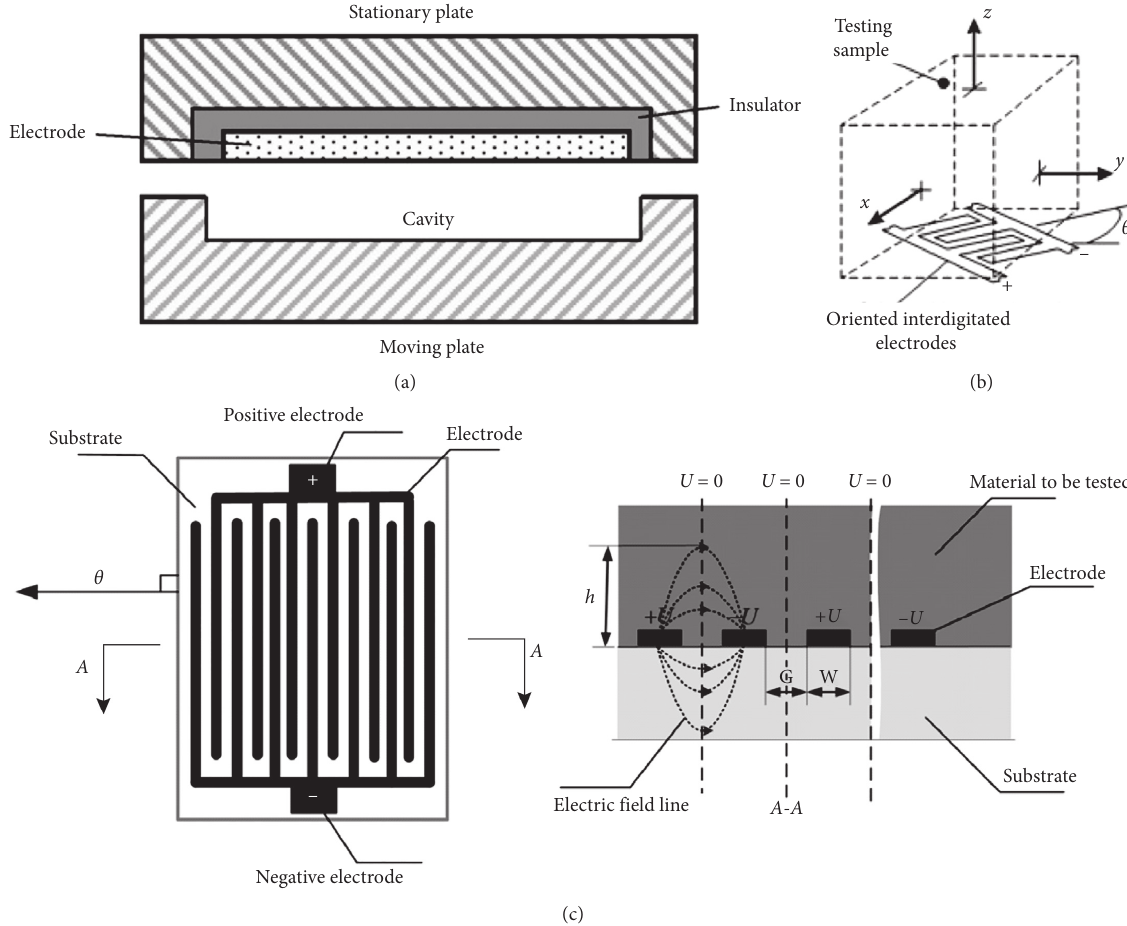
Figure 8: (a) Schematic view of the capacitive transducer installed in the injection mold [68]. (b) Interdigitated electrodes located in the xy - plane form an angle, θ , with respect to the y -axis [70]. (c) Schematic diagram of interdigitated